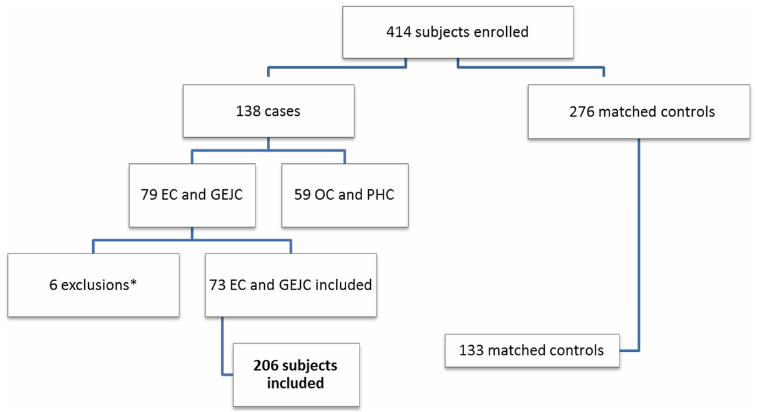
Fig 1. Number of cancer cases and matched controls included in the analysis. EC: esophagealcancer; GEJC: Gastro-esophagealjunction cancer; OC: oral cancer; PHC: pharyngeal cancer. * Exclusions: 2 stomach cancer cases, 3 non-primary esophageal cancer cases (relapse), 1 eligibleEC case refusing to completethe study questionnaire.